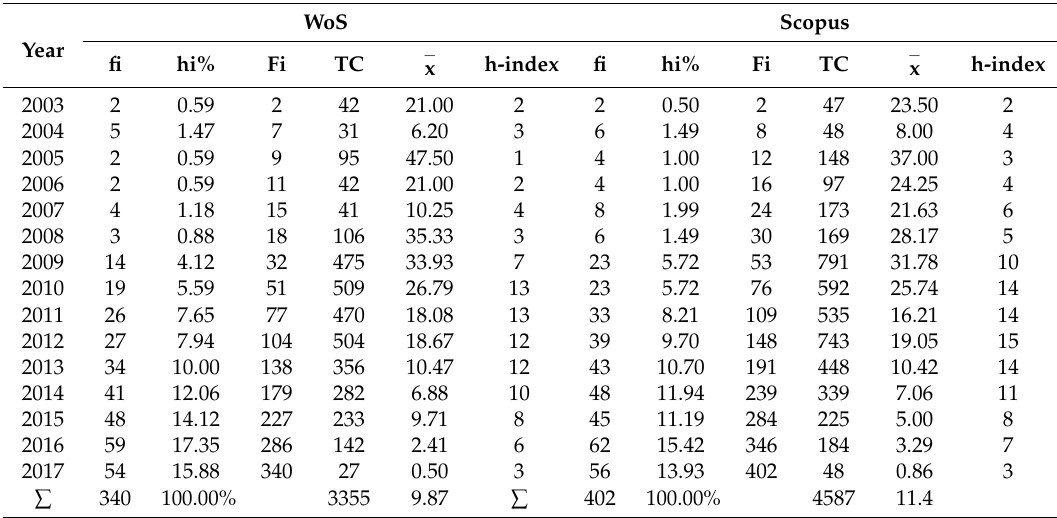
Table 1. Production of articles per year on water government.